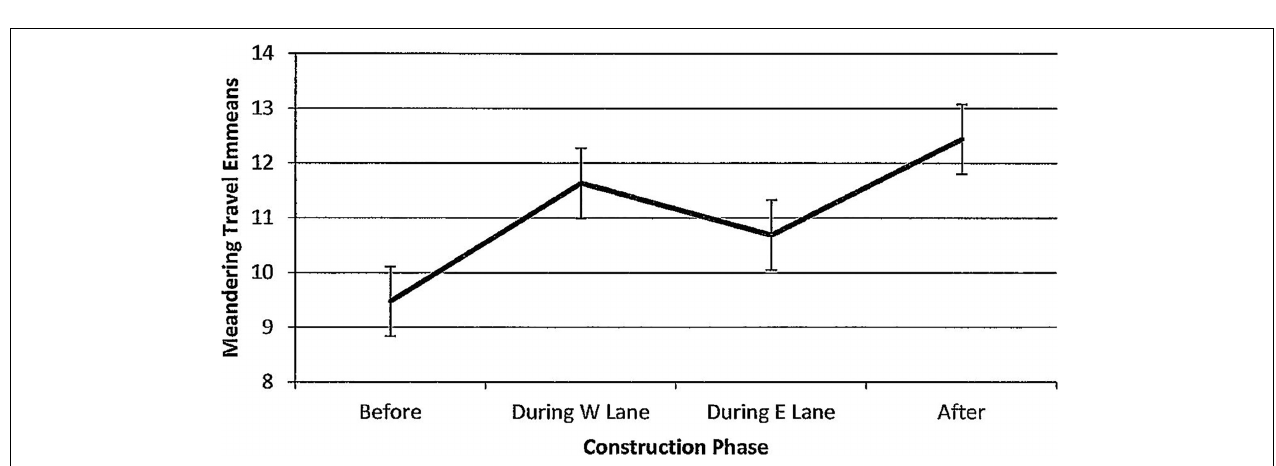
FIGURE 13 | Estimated marginal means of numbers of dolphins socializing in the construction zone before, during, and after construction.